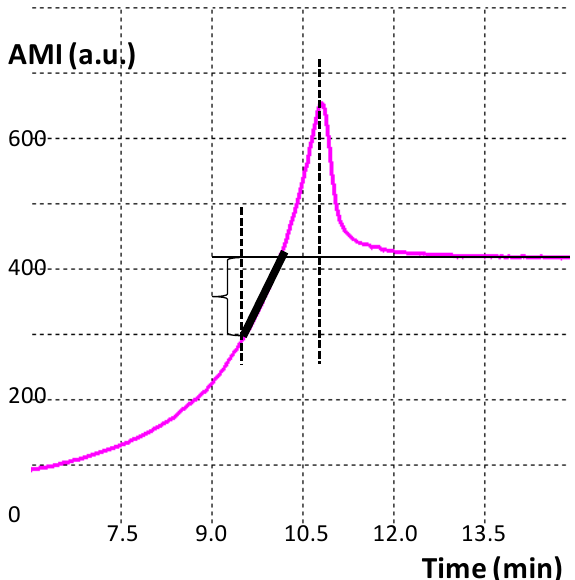
Figure 2. Calculation of SI-1: finding reference points and determining design parameters characterizing the shape of the amplitude curve of a drying drop. SI-1 is the total derivative on the section of the curve marked in